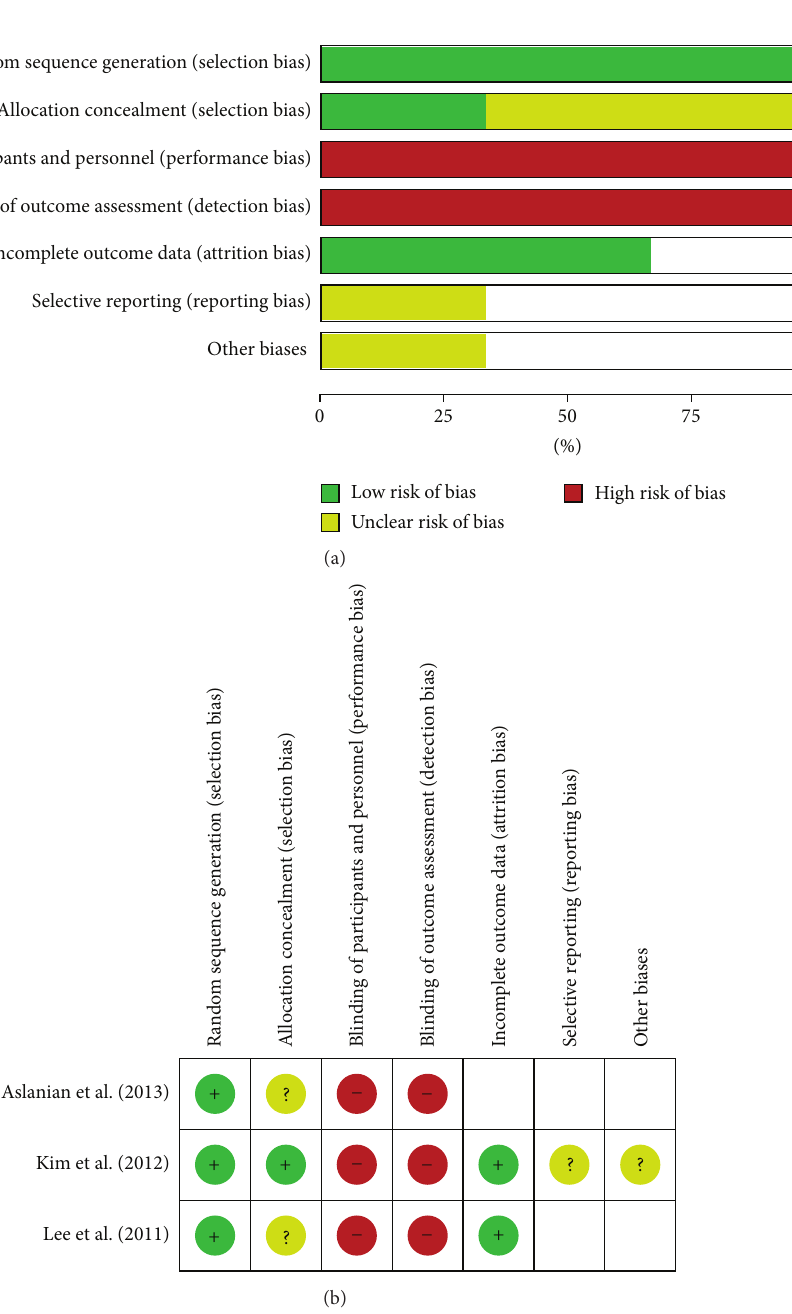
Figure 2: (a) Risk of bias graph. (b) Risk of bias